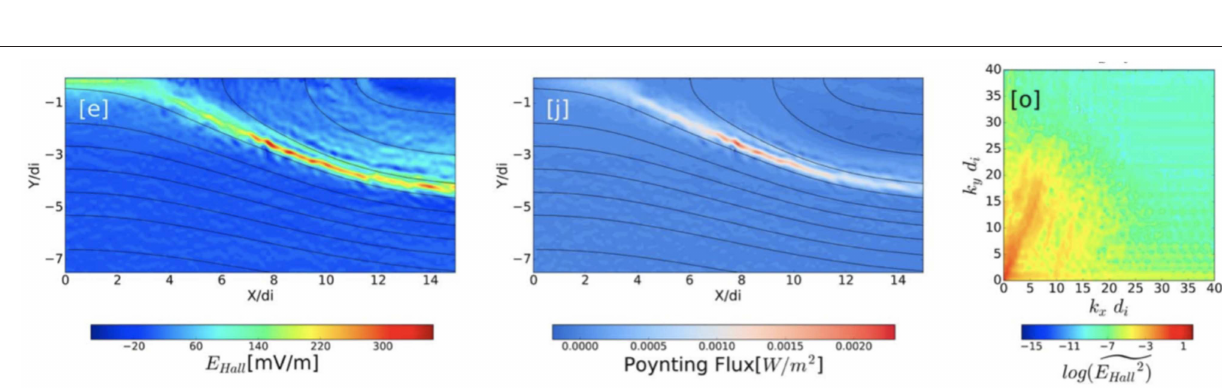
FIGURE 11 | Kinetic Alfvén wave observations in the separatrix region using 2D PIC simulations (Huang et al., 2018). (Left) Hall electric field corresponding to KAW generated in reconnection diffusion region. (Middle) Poynting flux in X-direction showing large Poynting flux carried by KAW along the separatrix region away from the reconnection site. (Right) wave-number spectrum that shows that large amplitude electric fields are almost field aligned structures with perpendicular scale comparable to the ion kinetic scales and thus being consistent with KAW